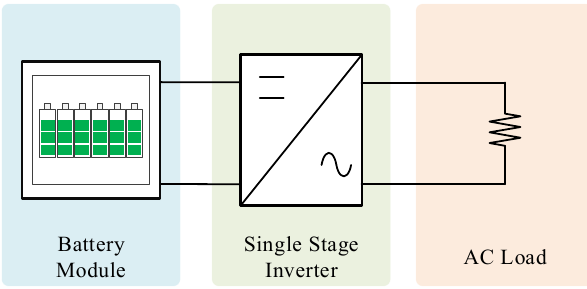
Figure 3. Pseudo DC-link topology of a BESS.